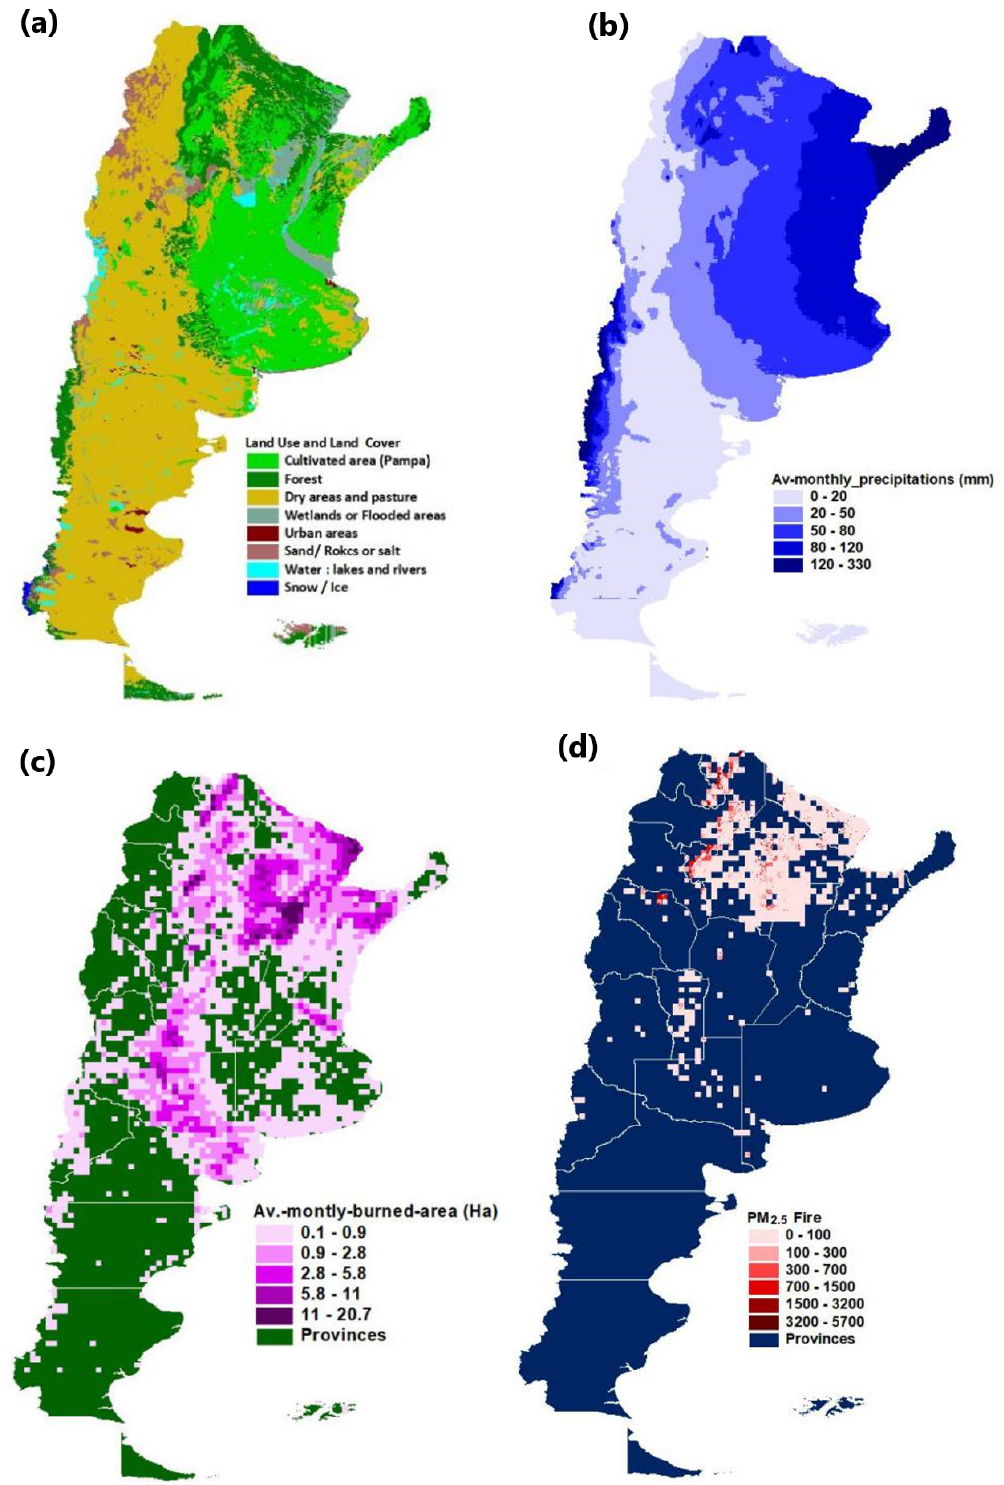
Figure A5. (a) Land types for Argentina. (b) Monthly average precipitation (millimeters per cell). (c) Monthly average burned area (hectares per cell). (d) PM 2 . 5 emissions in (kilograms per cell) for September